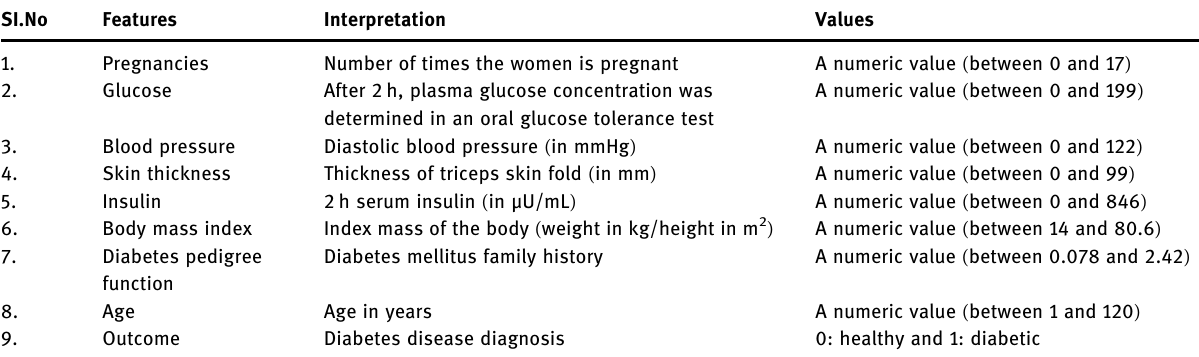
Table 2: Description of features of the datasets